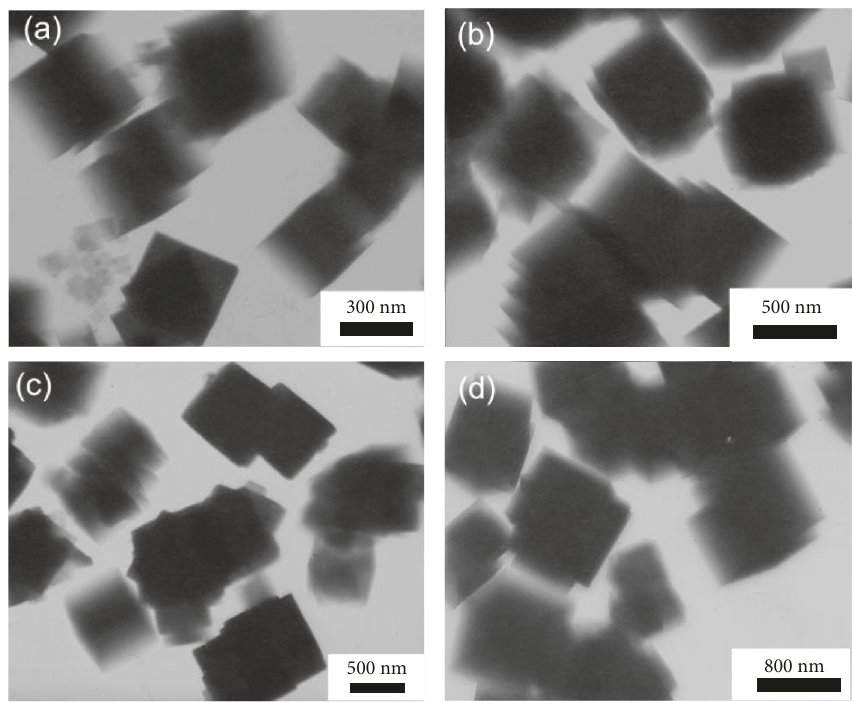
+ , 3 [Fe(CN) 6 ]: (a) 0.06 M H